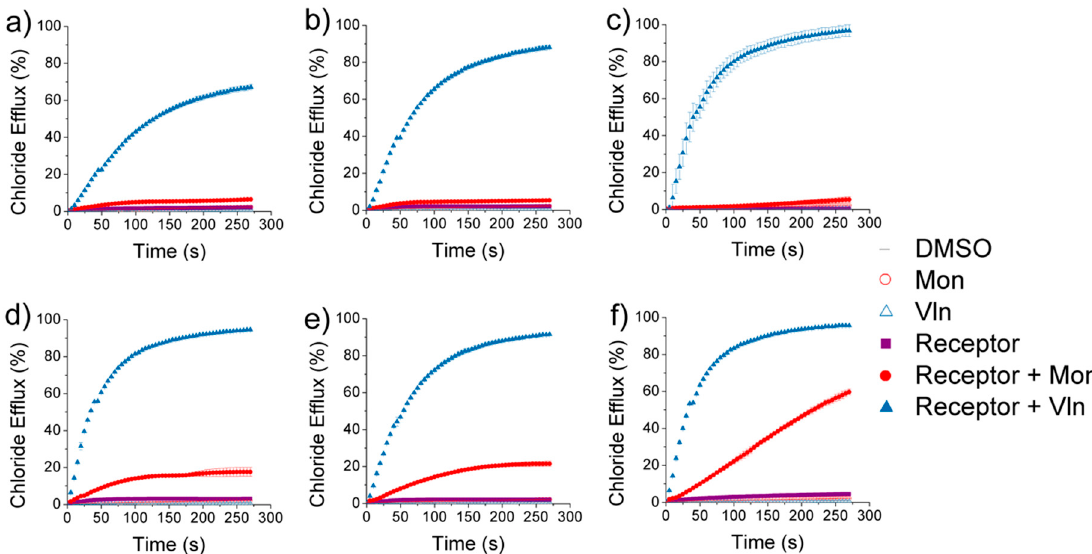
Figure 4. Results from the cationophore coupled assay. Chloride efflux facilitated by receptor (filled purple), receptor coupled to valinomycin (0.1 mol%, filled blue), and receptor coupled to monensin (0.1 mol%, filled red). The cationophore was added at t = − 30 s, the receptor was added at t = 0 s, and detergent was added at t = 300 s. DMSO (grey), valinomycin (empty blue), and monensin (empty red) were tested as controls and each data point is the average of two repeats with the error bars showing the standard deviation. ( a ) Receptor 1 (0.1 mol%). ( b ) Receptor 2 (0.1 mol%). ( c ) Receptor 3 (0.1 mol%). ( d ) Receptor 4 (0.1 mol%). ( e ) Receptor 5 (0.1 mol%). ( f ) Receptor 6 (0.5 mol%).